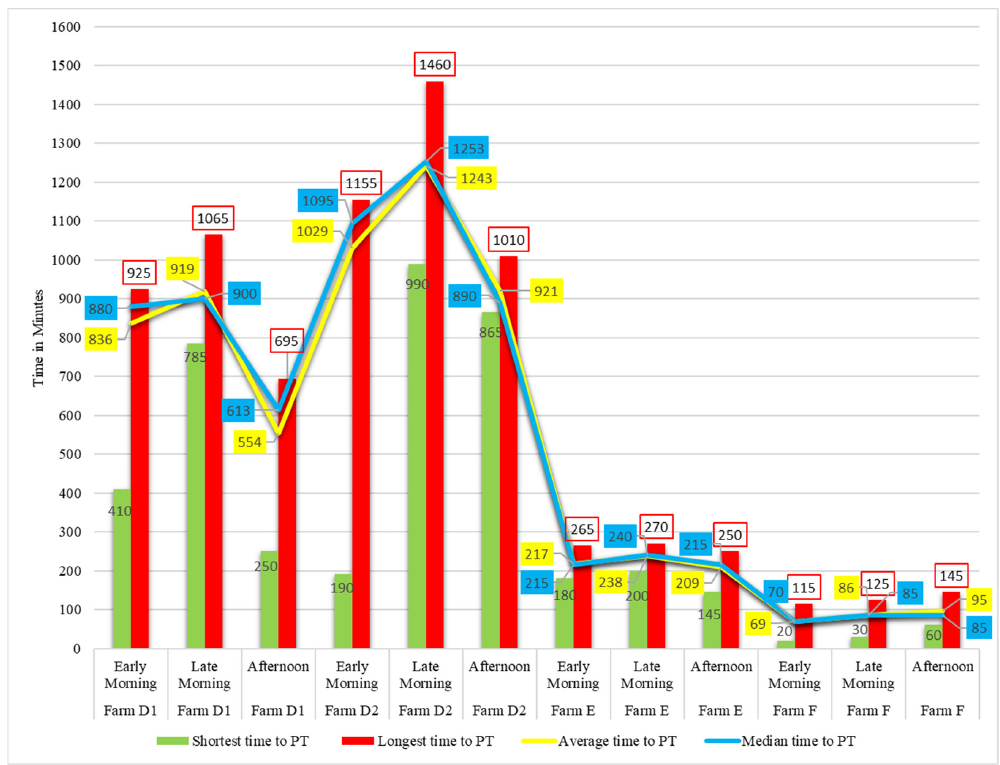
Figure 7. Time in minutes to reach PT = 6 °C on Gauteng farms. Source: [13].